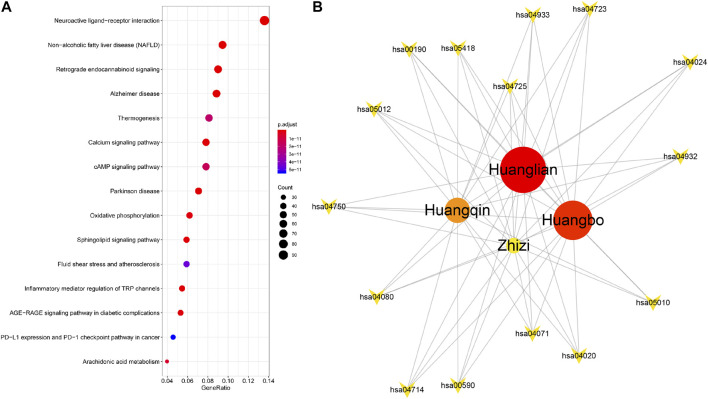
Gene enrichment analysis of all targets from HJD (A). botanical drug-pathway network of HJD (B). The circle nodes represent botanical drugs, and the inverted triangle represents the top 15 pathways of HJD. The size and color of the node represents the importance of the herbal regulation pathway.